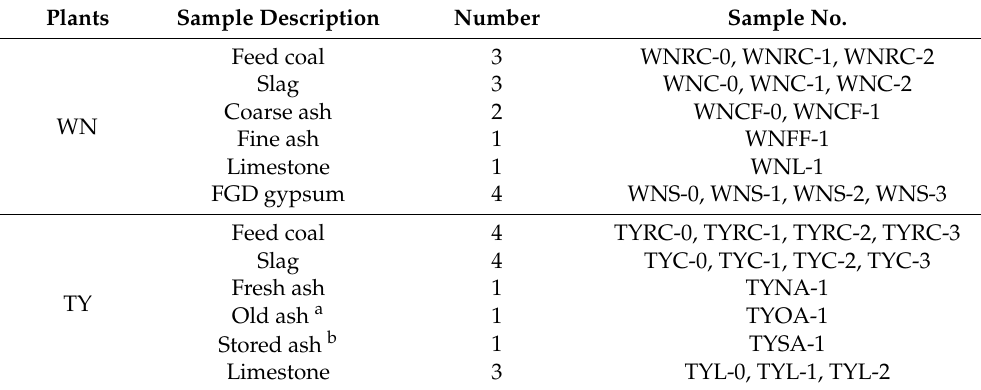
Limestone TYL-0, TYL-1,